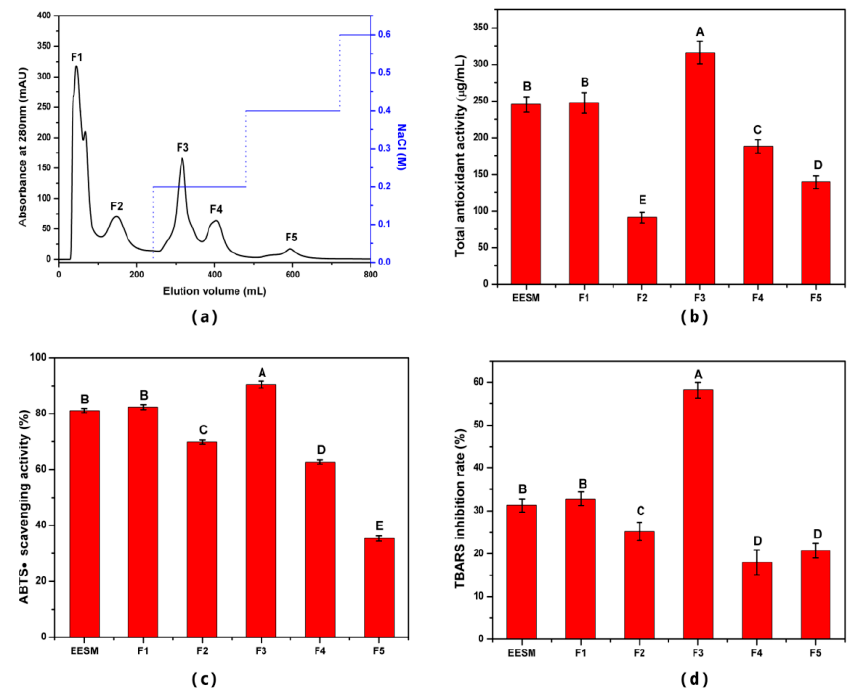
Figure 6. ( a ) Separation of ESM-EH by cation exchange chromatography. ( b ) TAA, ( c ) ABTS • scavenging rate, and ( d ) TBARS inhibition rate of isolated fragments. The di ff erent capital letters indicate significant di ff erences ( p < 0.05).